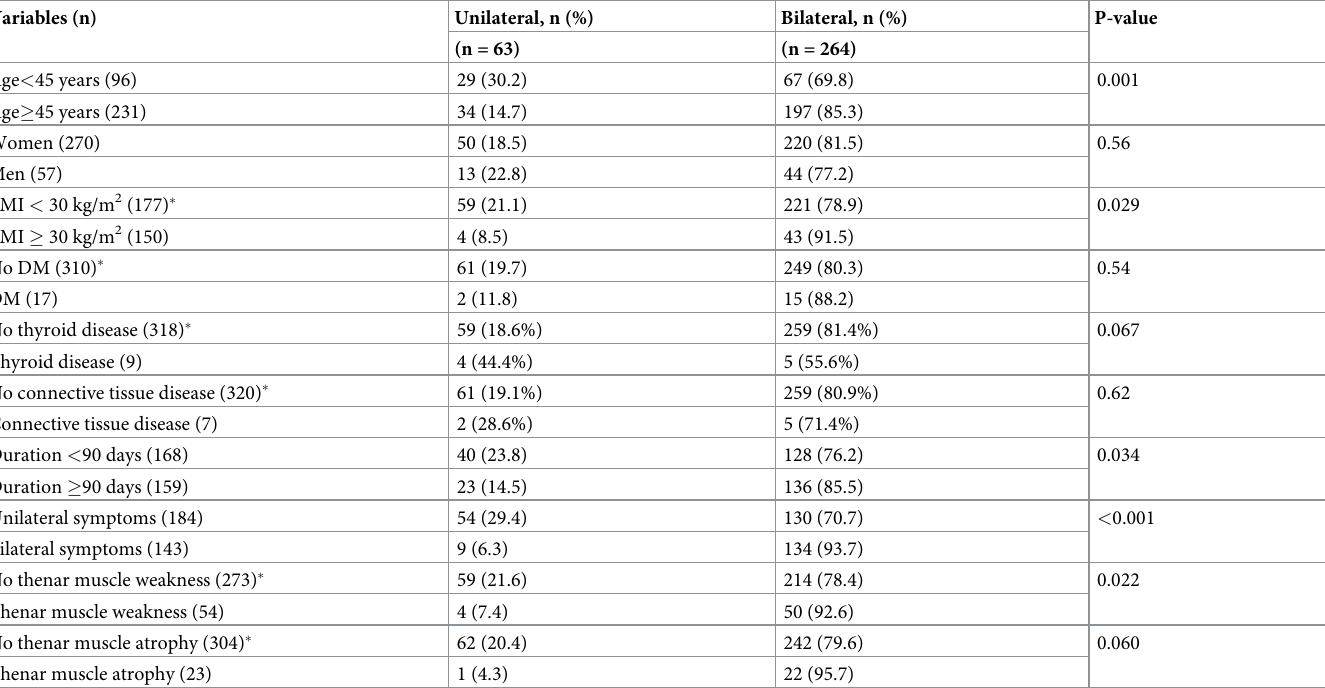
Table 3. Factors associated with bilateral CTS.